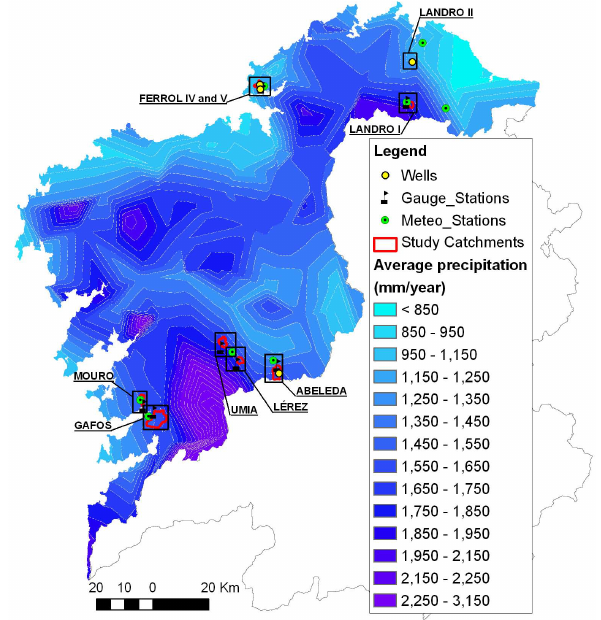
Fig. 3. Location of weather stations, wells and discharge gauge sta- tions used for modeling the study catchments, and average precipi- tation map for Galicia-Costa built with data from Hydrological Plan of Galicia-Costa (Xunta de Galicia,